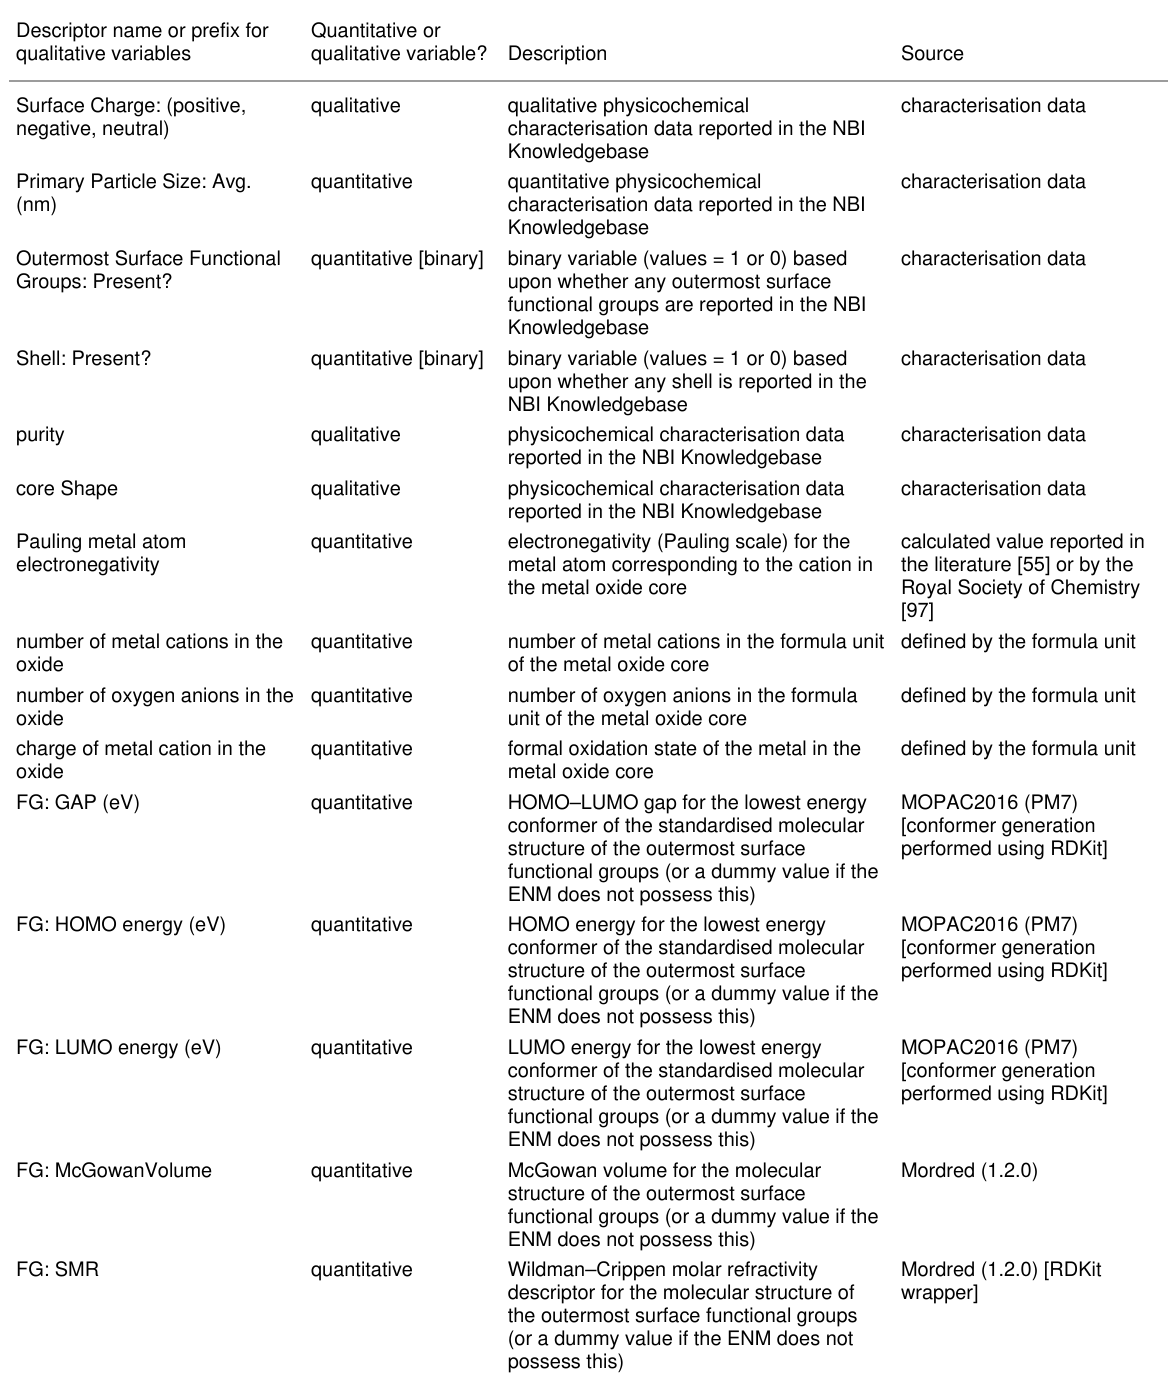
Table 3: Summary of all descriptor names, or prefixes for the one-hot-key encoded qualitative variables, reported in Supporting Information File 2, along with a description of how they were derived. Descriptor name or prefix for qualitative